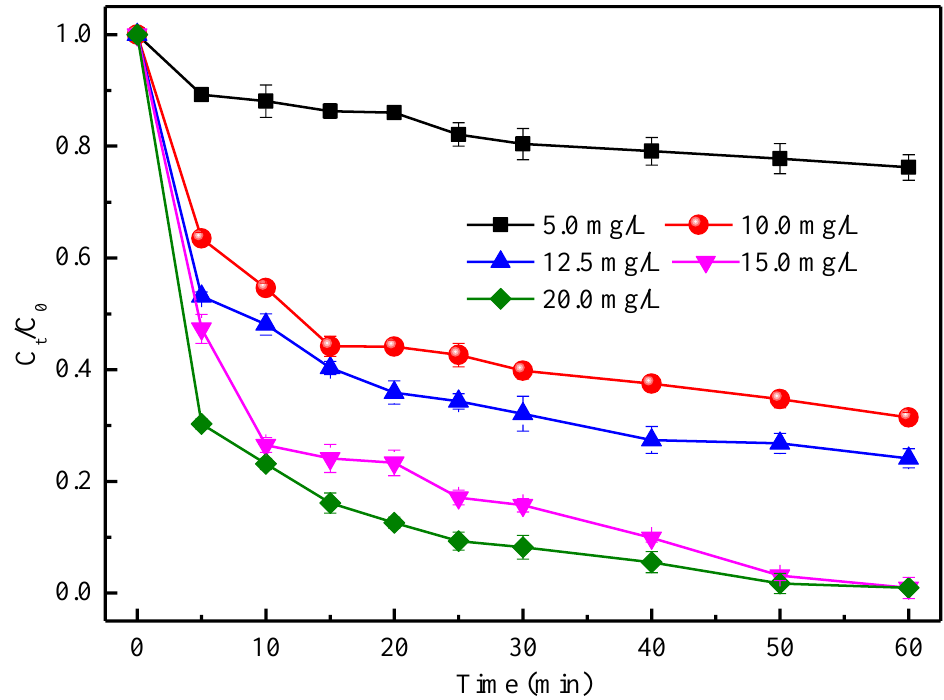
Figure 5. Effect of CMC-FeS dosage on TC removal. C 0 (mg/L) and C t (mg/L) are the TC concentrations at the initial time and at time t , respectively. Conditions: C 0 = 50 mg/L, CMC-to-FeS mass ratio = 1:2, Initial pH = 7.0; thermostatic oscillator (150 rpm, 25 ± 1 °C ).